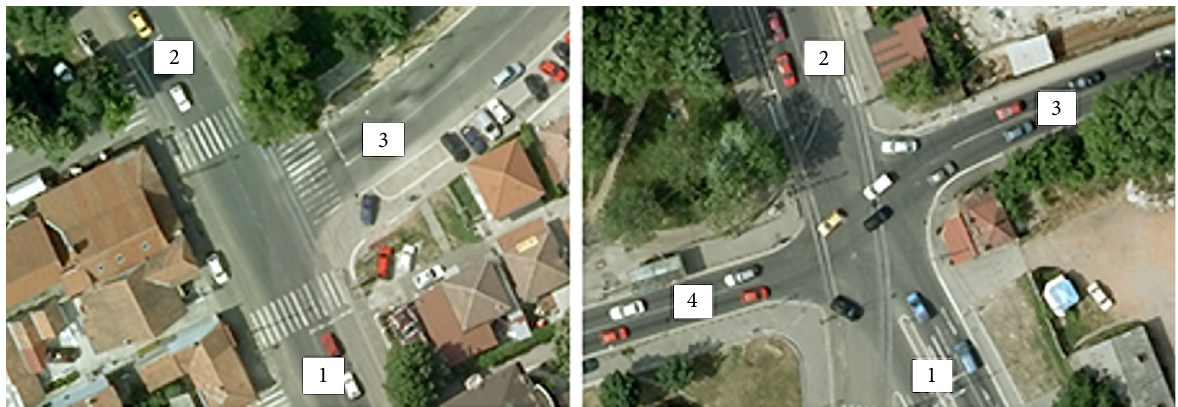
Fig. 2. Researched locations: a – 3-leg intersection; b –